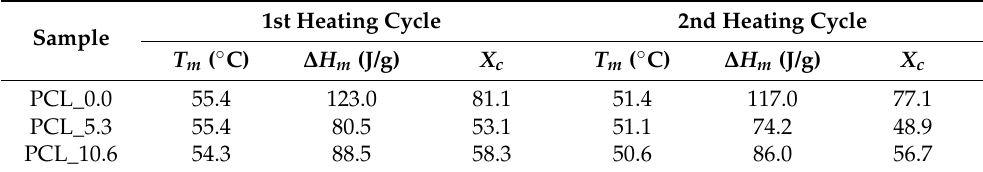
Table 1. Melting temperature and crystallinity degree of electrospun mats of PCL/ P. major